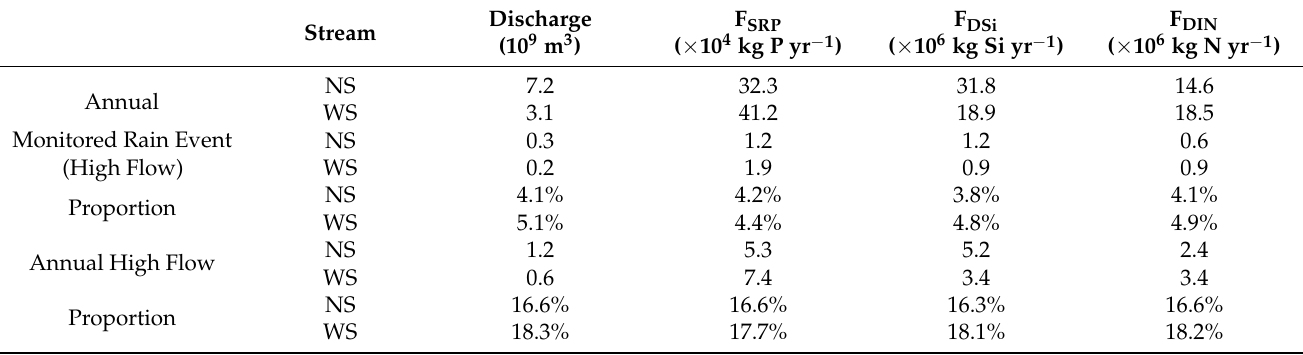
Figure 7. The relationship between the cumulative nutrient loads (( a ) DIN, ( b ) SRP and ( c ) DSi) and river discharge. The black line represents the 1:1 line, indicating that the nutrient loads were proportional to the increase in river discharge. The datapoints above/below the 1:1 line indicate that the nutrient loads were predominantly exported toward the start/end of the rain event, respectively. Table 3. The fluxes and proportions of nutrient loads during the rain